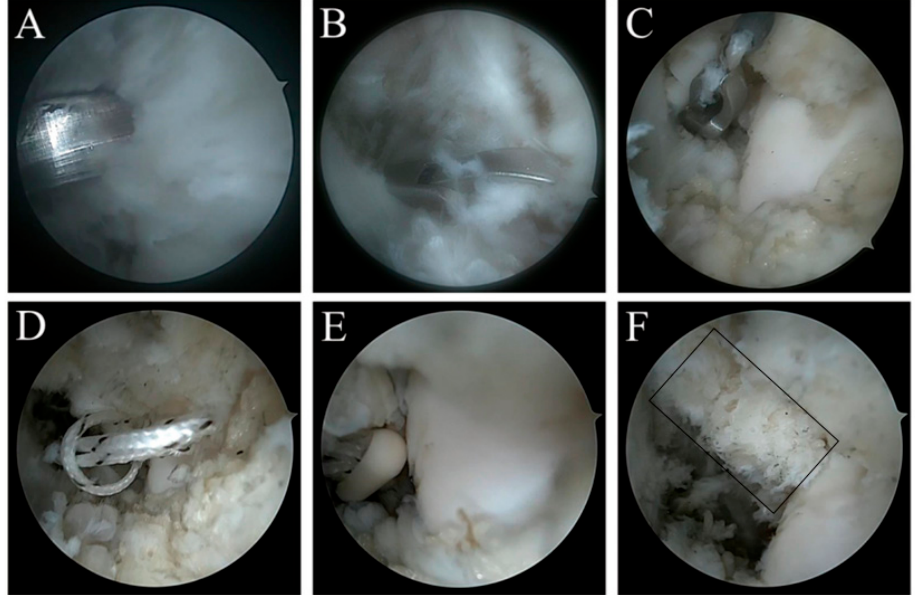
Figure 4. ATFL ATiFL-DF transfer augmentation repair under total arthroscopy. ( A , B ): ATiFL-DF was separated from the lateral tibial insertion by osteotomy. ( C ): The stapler passes through the free ATiFL-DF. ( D ): The ring is sleeved with the free ATiFL-DF. ( E ): The talus side was implanted with knotless anchor. ( F ): Postoperative effect.